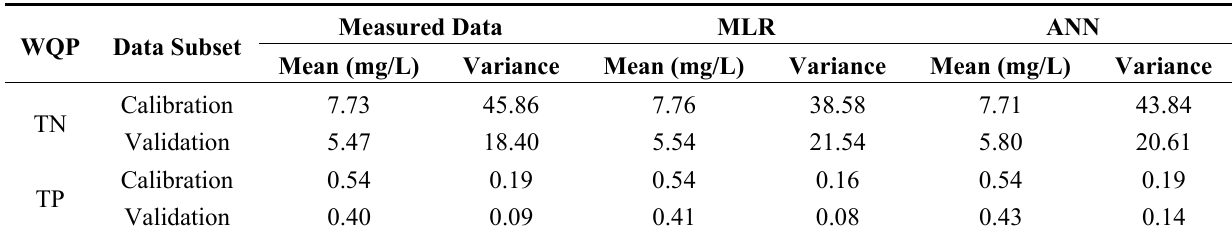
Table 7. Summary statistics of measured WQPs and estimated WQPs by two